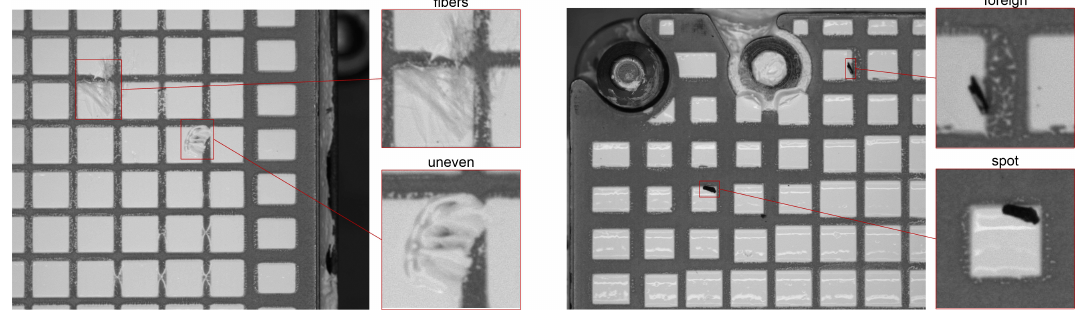
Figure 13. Two pairs of easily confusing